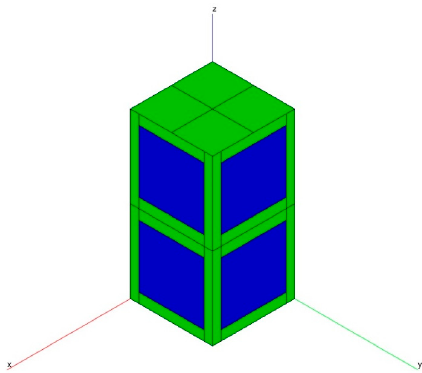
Figure 13. Thermal model of a double unit Cubesat including solar cells (blue) and structure (green).